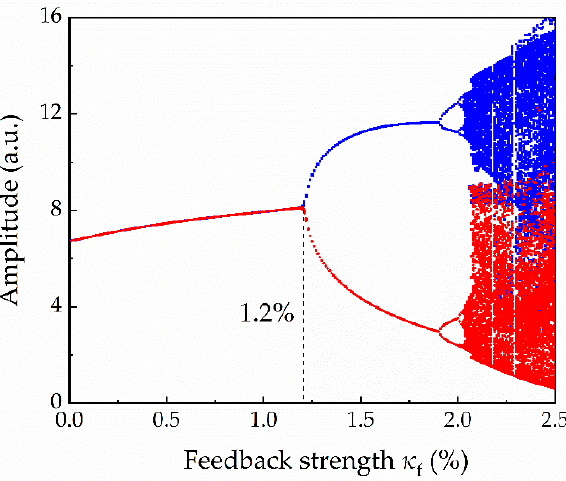
Figure 3. The bifurcation diagram of the CSHR microlaser as a function of feedback strength κ f , with I = 12 I th and τ = 0.1 ns.